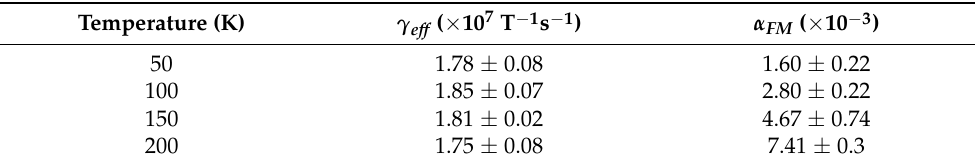
Figure 5. ( a ) FMR spectra of GdIG 60 nm samples at 15 GHz RF frequency. The horizonal axis (field axis) is shifted as much as the resonance field to compare the linewidth for different temperatures. ( b ) Resonance frequency as a function of the external field at 50 K and the Kittel formula fitting (red line). ( c ) Frequency dependence of peak-to-peak FMR linewidth. The solid line represents linear fitting. ( d ) Temperature dependence of damping parameters 𝛼 𝐹𝑀 and 𝛼 𝐹𝑖𝑀 . Table 3. Effective gyromagnetic ratio ( 𝛾 𝑒𝑓𝑓 ) and damping parameter ( 𝛼 𝐹𝑀 ) measured at various temperatures below T M .